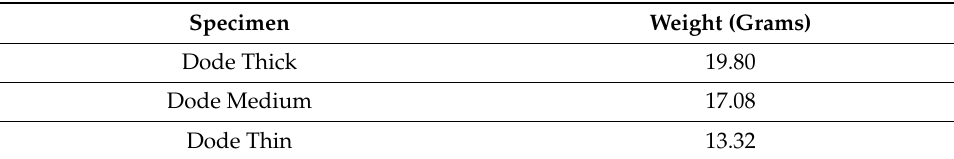
Table 1. Weighing scale reading of the three